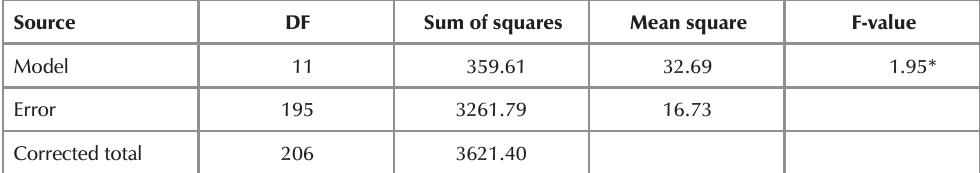
F-test for type of organisation and level of unethical